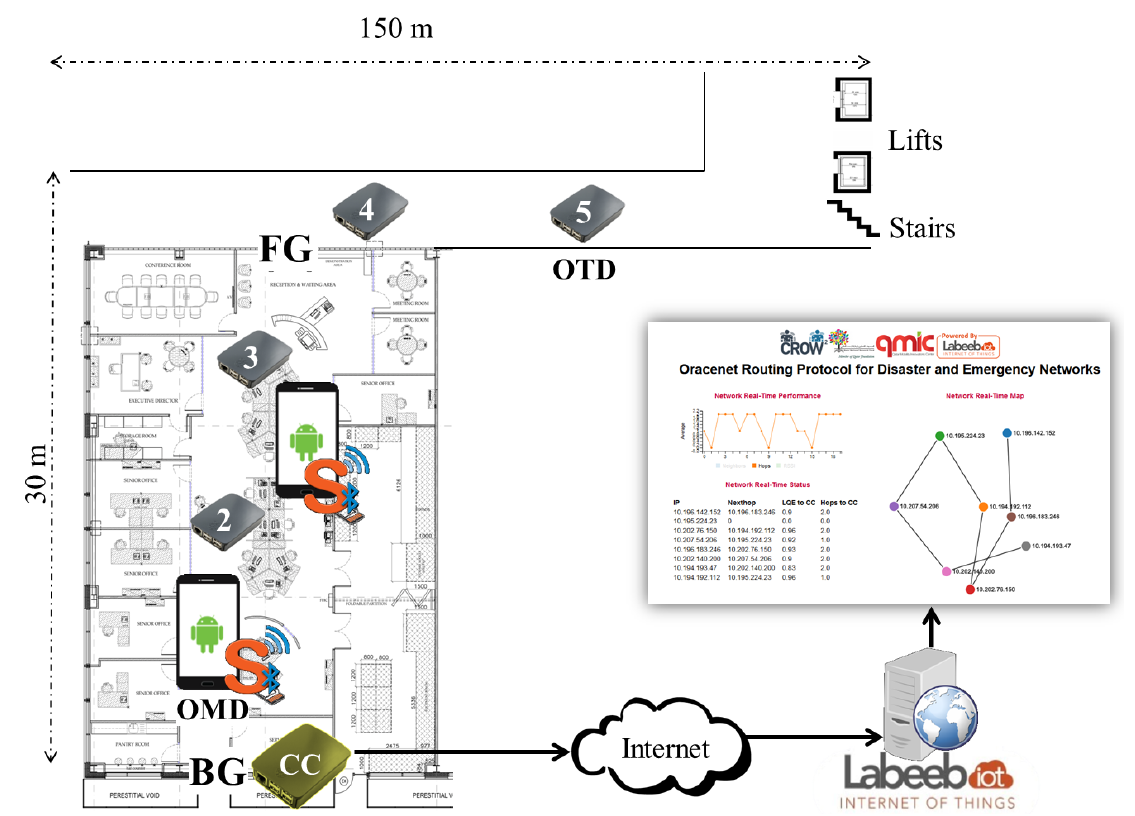
Figure 5. Experimentation scenario and data flow from deployed nodes to the Labeeb-IoT platform. The Command Center (CC node) is placed at the Back Gate (BG); ORACE-Net Mobile Devices (OMD) are mobile devices carried by the rescuers to which Shimmer sensors are connected via Bluetooth. The tactical ORACE-Net network is established through ORACE-Net Linux Tactical Devices (OTD). All collected data go through the CC node to the Labeeb-IoT platform. A real-time dynamic topology website instantly displays the network topology.